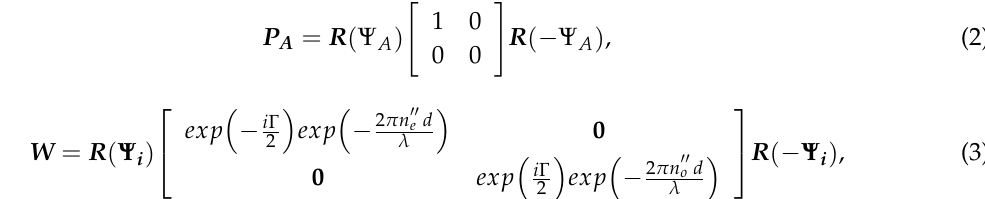
Figure 3. Experiment setup for terahertz measurements.